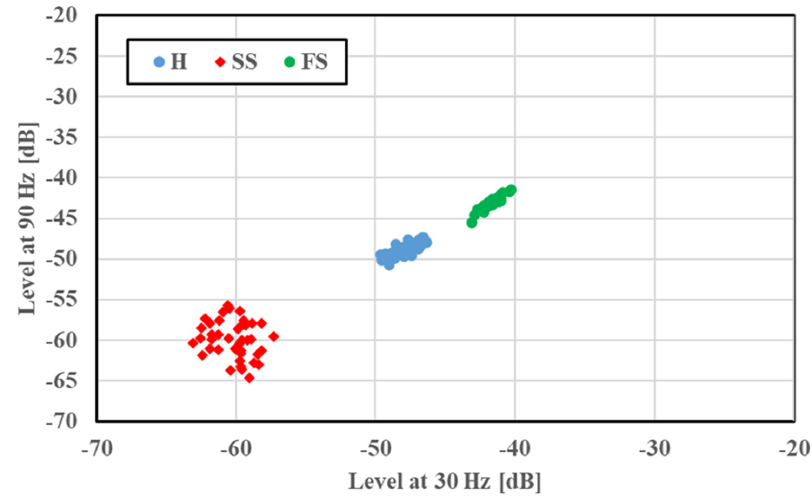
Figure 5. Feature distribution of H, SS, and FS at 1765 min − 1 .